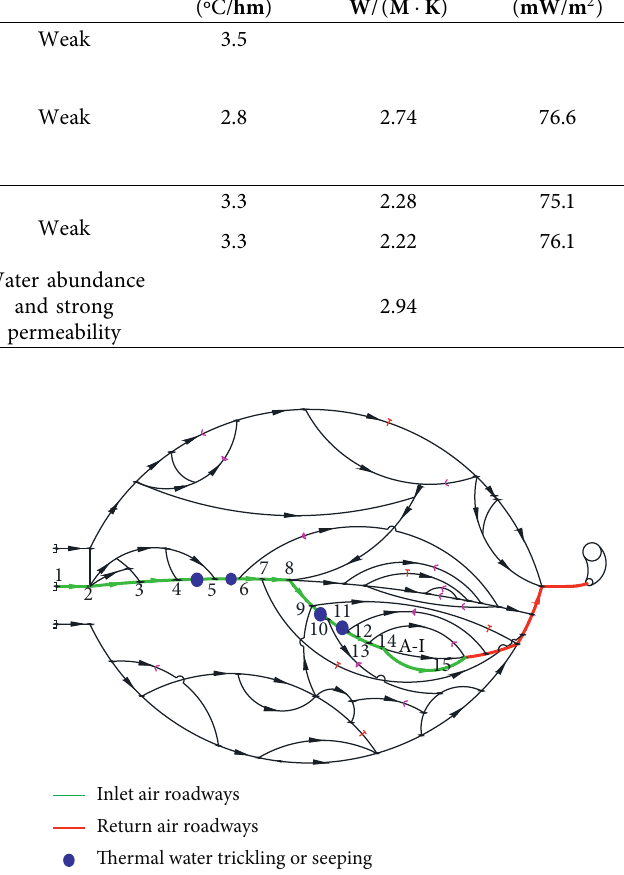
Figure 2: Ventilation route of the A-I working face in Sanhejian Coal